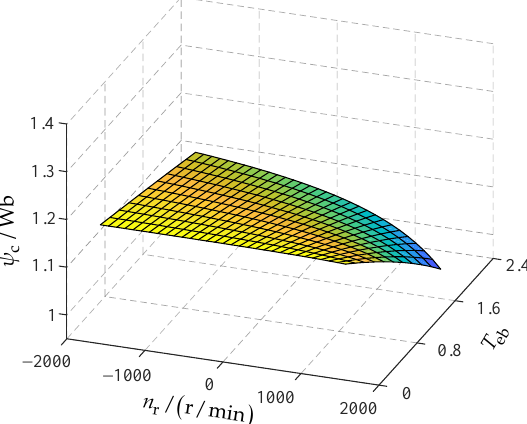
Energies 2021 , 14 , 6402